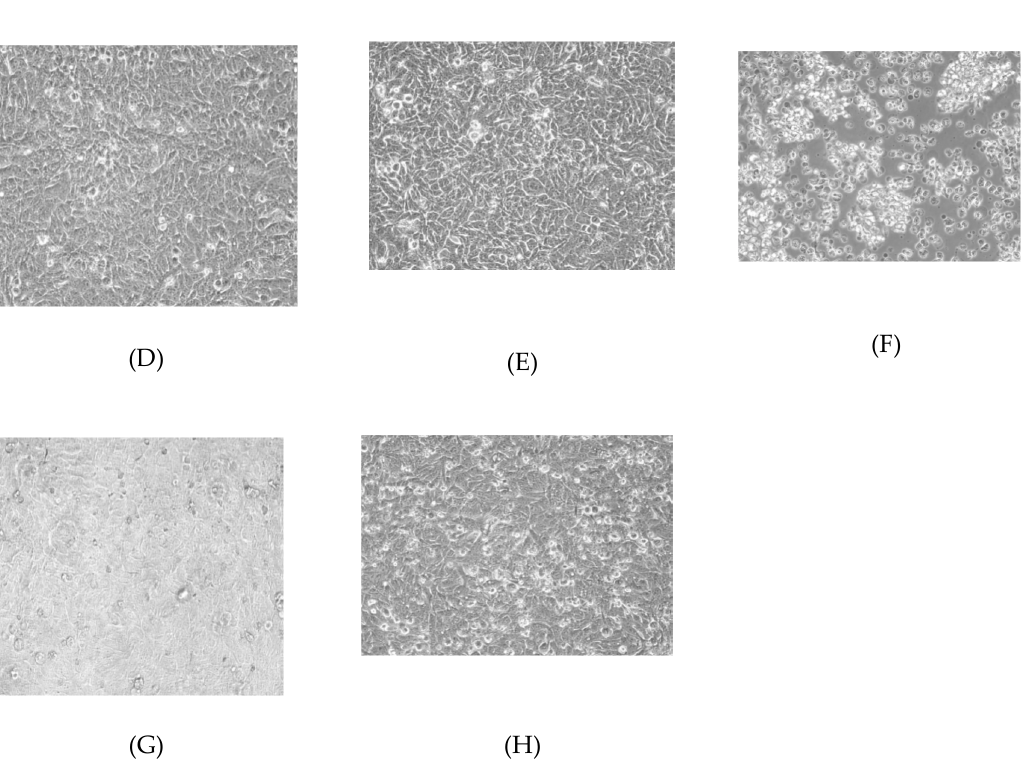
Figure 2. E ff ects of multiple kinase inhibitors on the HepG2 cell viability cells ( n = 3), ( A ) sorafenib; ( B ) regorafenib; ( C ) lenvatinib. HepG2 cells were treated with sorafenib, regorafenib, or lenvatinib at 0, 1, 2, 5, 10, or 20 µ M for 48 h. ( A ) sorafenib; ( B ) regorafenib; ( C ) lenvatinib. Cell viability was measured by MTS assay. * p < 0.05, compared to HepG2 treated without multiple kinase inhibitors. Pictures taken by phase contrast microscopy ( × 20): ( D ) HepG2 control; ( E ) HepG2 cells treated with 2 µ M regorafenib; ( F ) 20 µ M regorafenib; ( G ) 2 µ M lenvatinib; ( H ) 20 µ M lenvatinib.